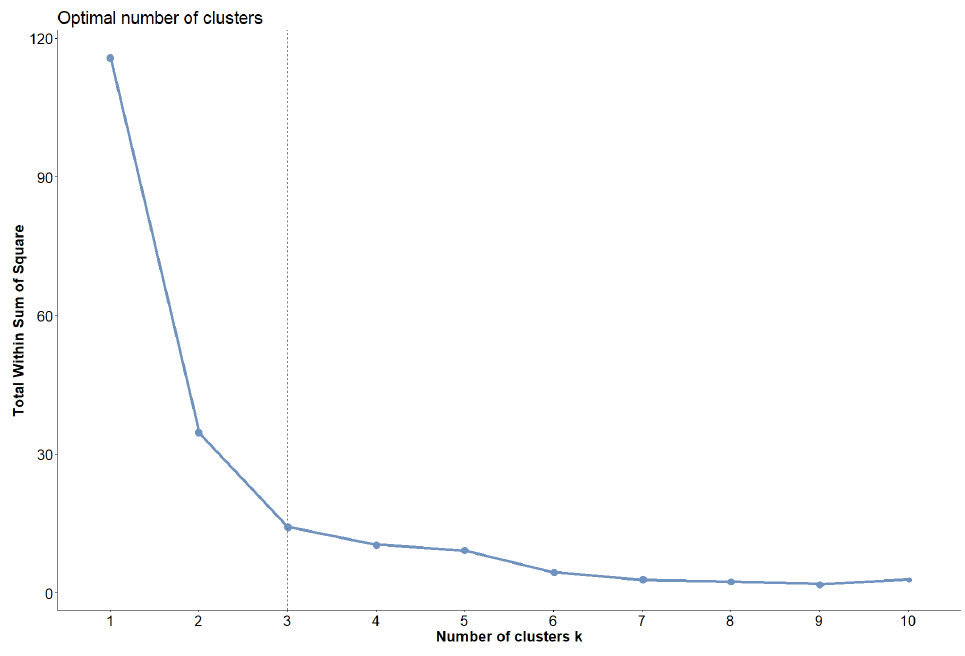
Figure 6: Identification of the optimal number of clusters using the elbow criterion for k-means clustering